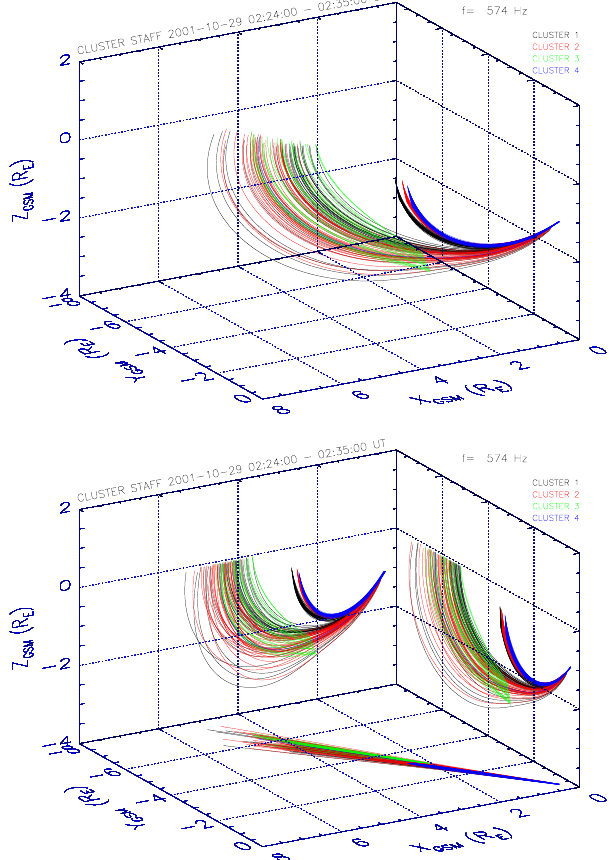
Fig. 5. The top panel represents the ray traces in 3-D for a frequency equal to 574Hz during the same time interval as Fig. 4. The bottom panel represents the same data but now only the projections of the ray traces on the three planes are plotted. The curves are colour- coded according to each